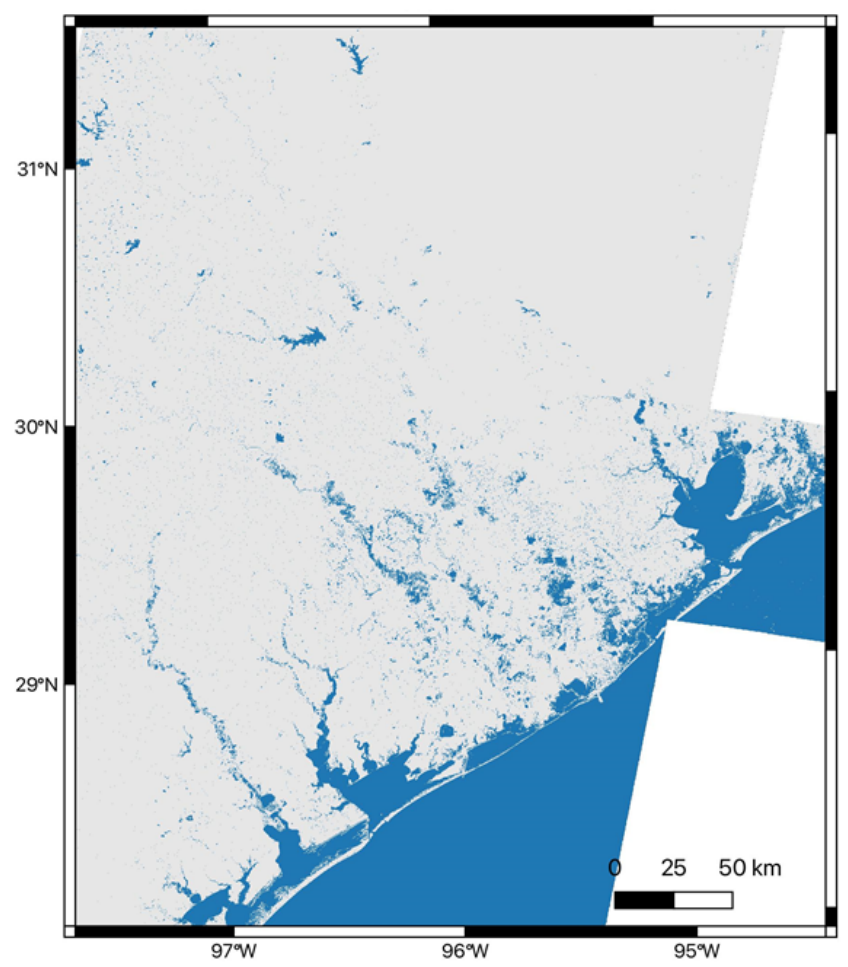
Figure 4. NDWI derived from Sentinel-2 images, acquired on 30 August and 1 September 2017. Water is shown in blue, and pixel spacing is 10 m.